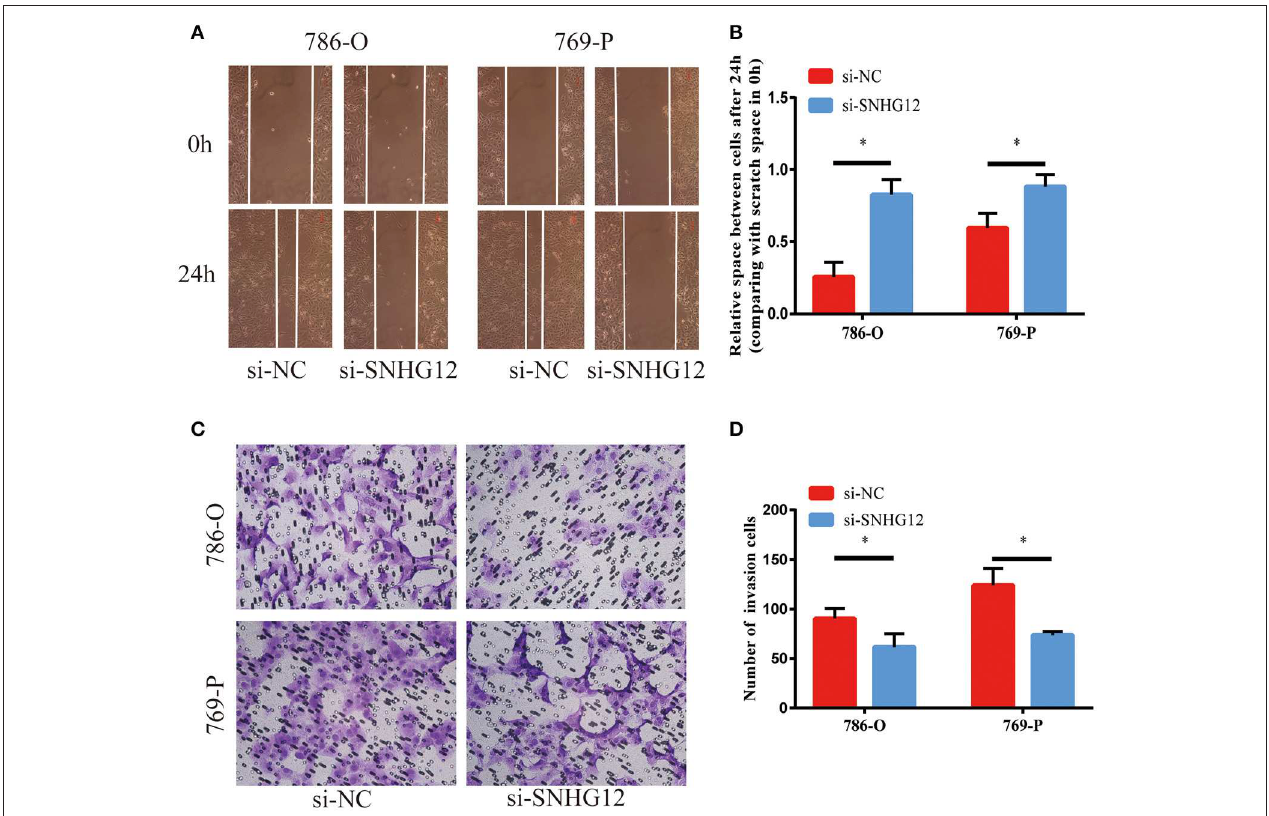
FIGURE 3 | Effects of SNHG12 on ccRCC cells’mobility in vitro . (A,B) Scratch wound assays were conducted to detect the migration abilities of si-SNHG12-transfected cells. Scratch wound assays were photographed at a magnification of 10X. (C,D) Transwell assays were conducted to detect the invasion abilities of si-SNHG12-transfected cells. Transwell assays were photographed at a magnification of 20X. Error bars stand for the mean ± SD of at least triplicate experiments. * P < 0.05.